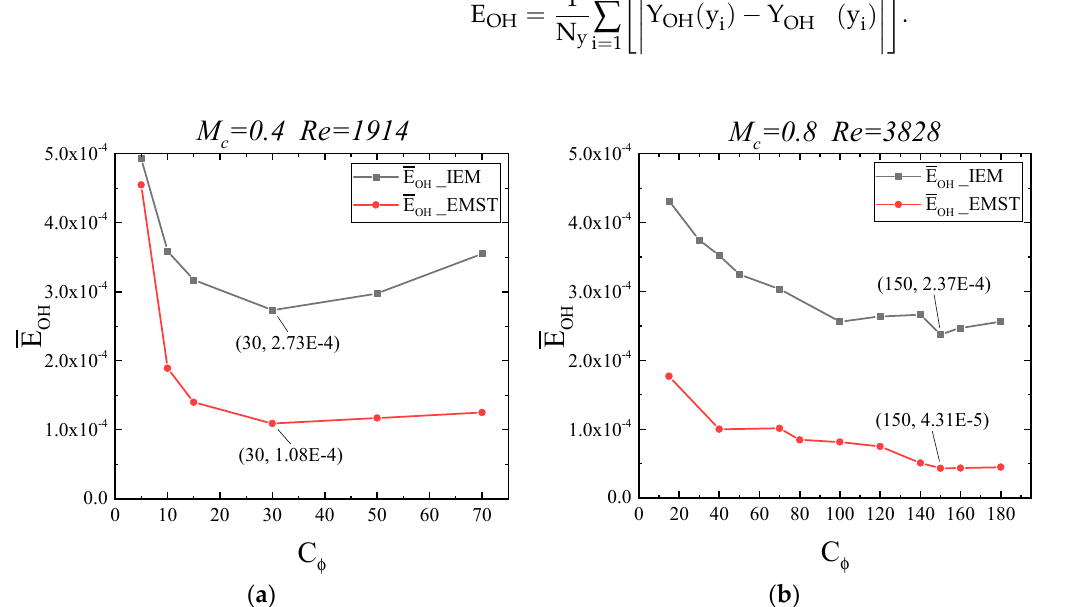
Figure 17. Mean deviation of OH mass fraction against mixing model coefficient obtained using IEM and EMST for ( a ) M c = 0.4 case and ( b ) M c = 0.8 case, respectively.